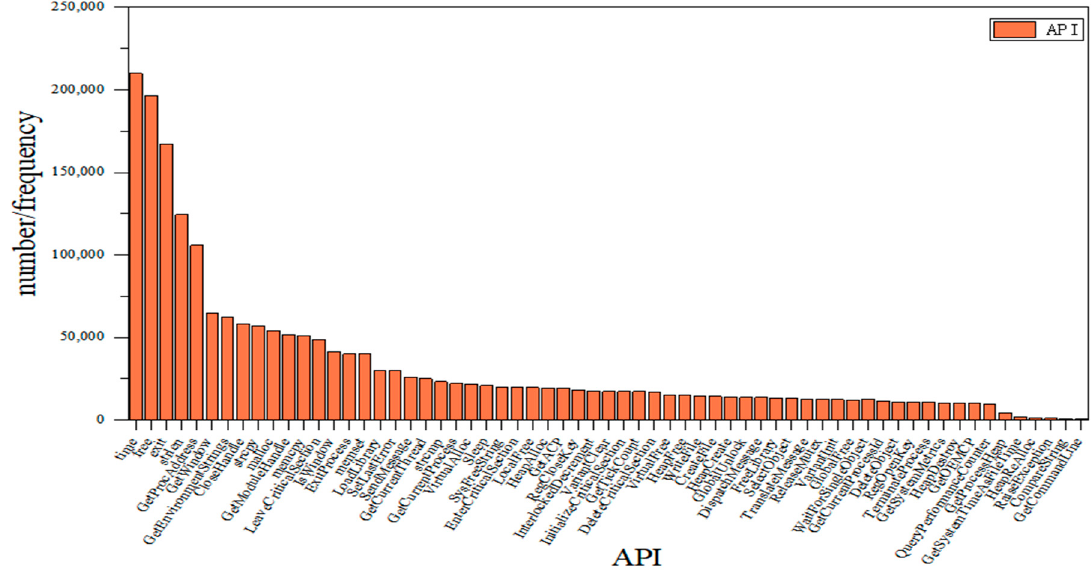
Figure 8. Ranking API in order of importance.